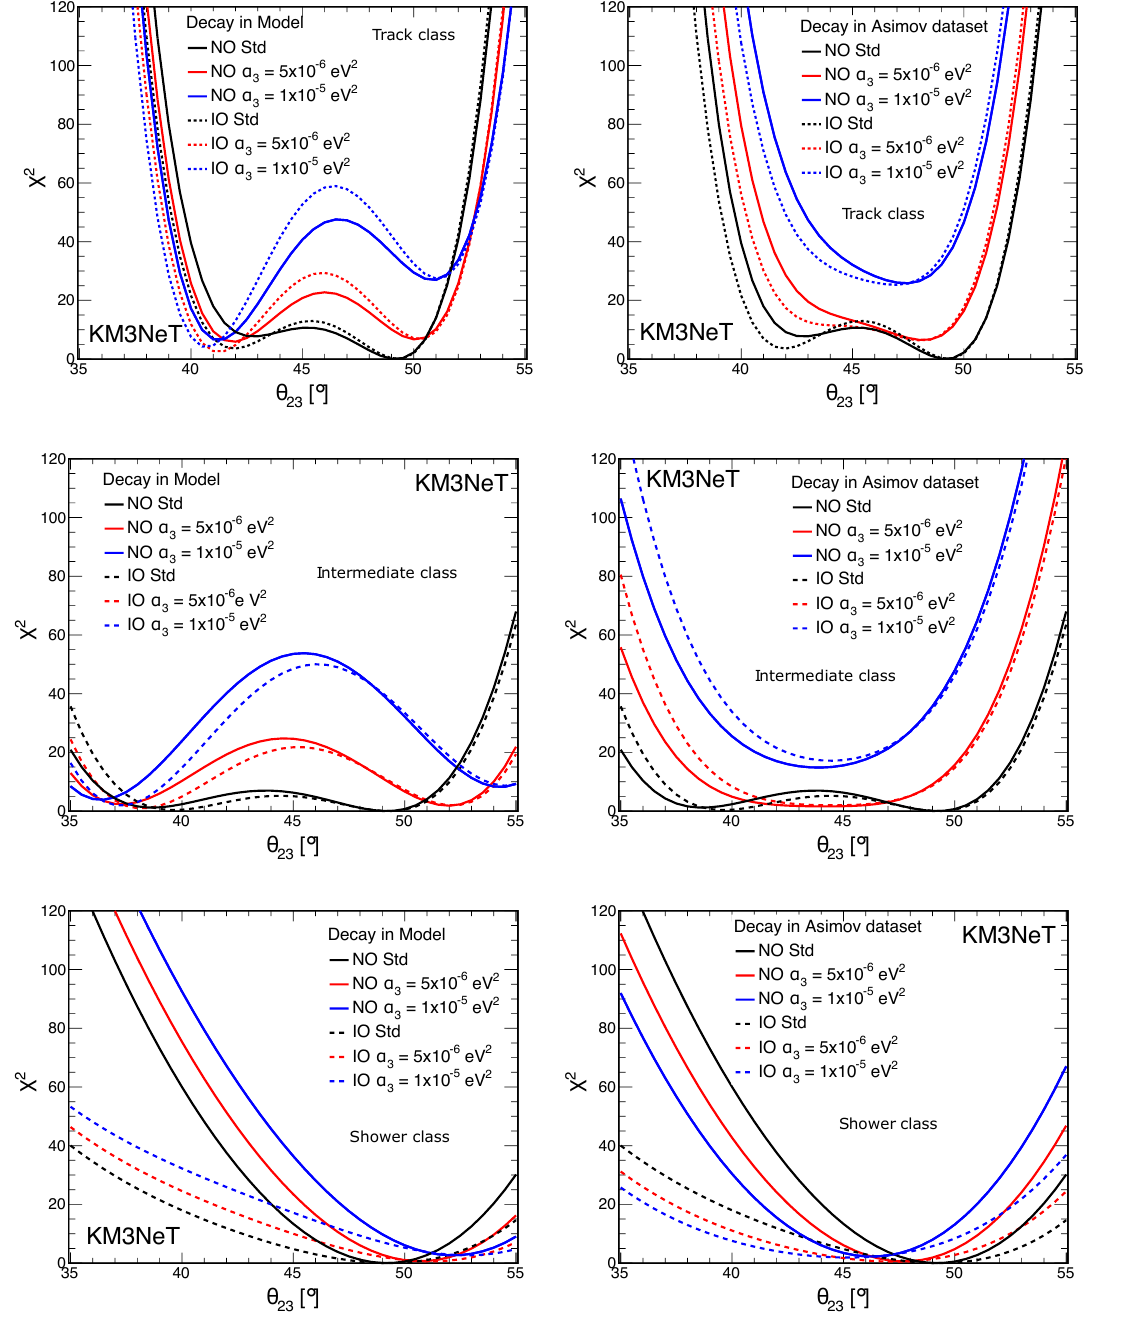
Figure 7. Statistical χ 2 as a function of the scanned value of θ 23 in the model for different values of α 3 fixed in the model (left) or in the Asimov dataset (right) for NO (solid) and IO (dashed) separated by class topology contributions: track-like (top), intermediates (middle) and shower-like (bottom). Three cases are considered, α 3 = 0 (black), α 3 = 5 × 10 − 6 eV 2 (red) and α 3 = 10 − 5 eV 2